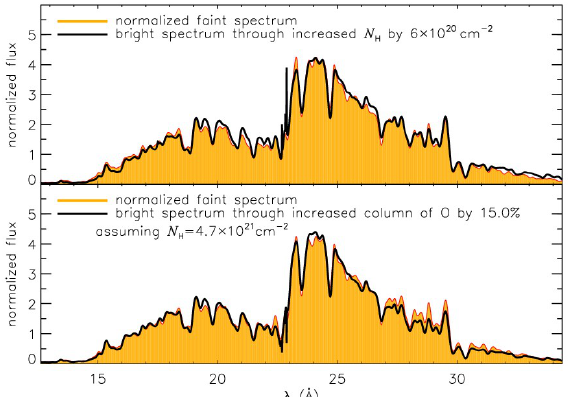
Figure 4: Testing two hypotheses to explain the spec- tral changes between hard/bright (blue shades in top panel of Fig. 3) and soft/faint (orange thick line in Fig. 3) spectra by the black thin lines. The normalized soft/faint spectrum is shown as orange shadings while the black line corresponds to two types of modifications of the bright/faint spectrum, also normalized (see text). Top : Overall increase of N H by 26% of N H , CS . Bot- tom : Increase only of O i column by changes in O abun- dance of